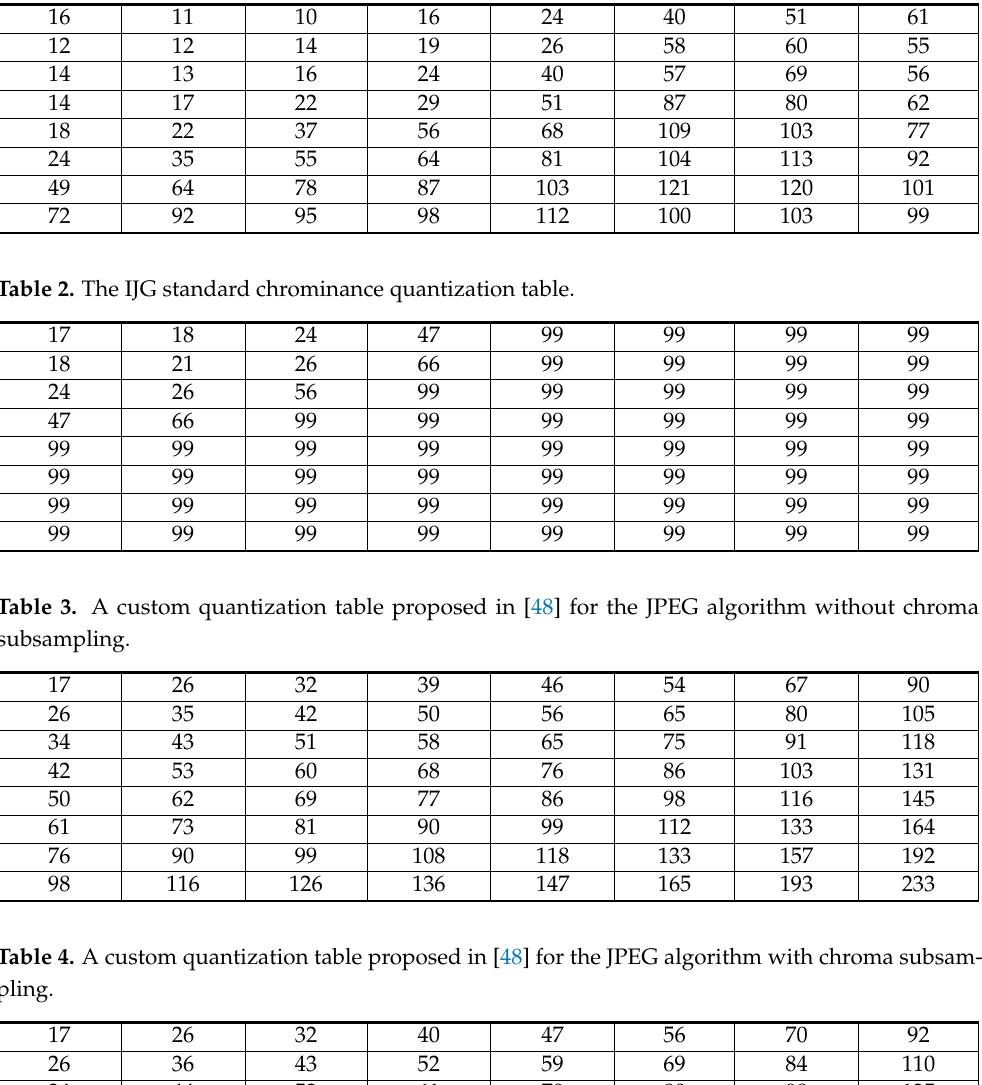
Table 1. The IJG standard luminance quantization table.